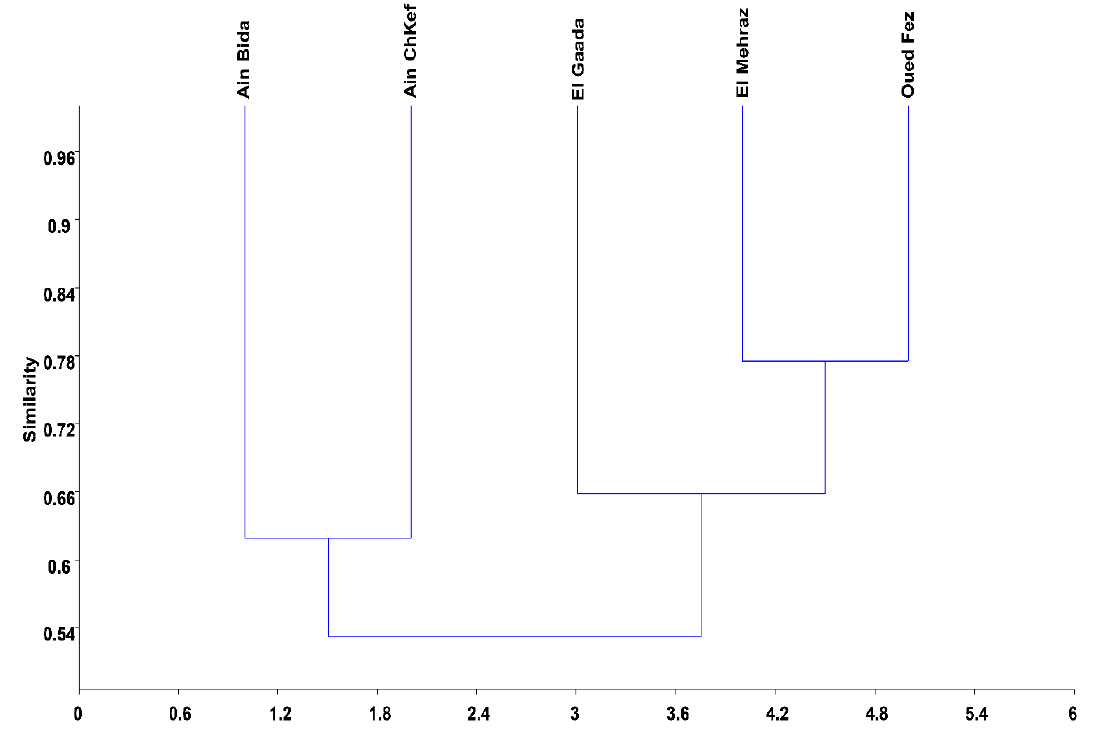
Figure 3. Bray–Curtis similarity coefficient ordination comparing studied sites based on avian com- munities . Table 2. Avian diversity among studied habitats in Fez peri-urban area between 2018 and 2019.